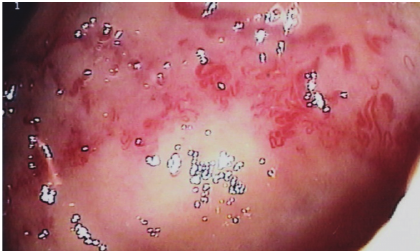
Figure 3: Torturous (corkscrew) vessels with dilatation at location of duodenoplasty.